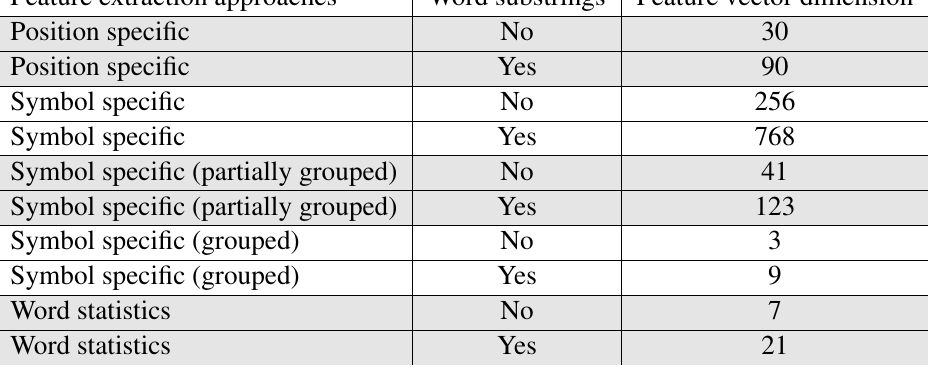
Table 1: The ten proposed feature extraction strategies. We apply the five feature extraction meth- ods Position specific , Symbol specific , Symbol specific (partially grouped) , Symbol specific (grouped) , and Word statistics either to the whole word string indicated by a ’No’ in the second column, or to three word substrings individually indicated by a ’Yes’ in the second column. In the third column, we present the dimension of the feature extraction